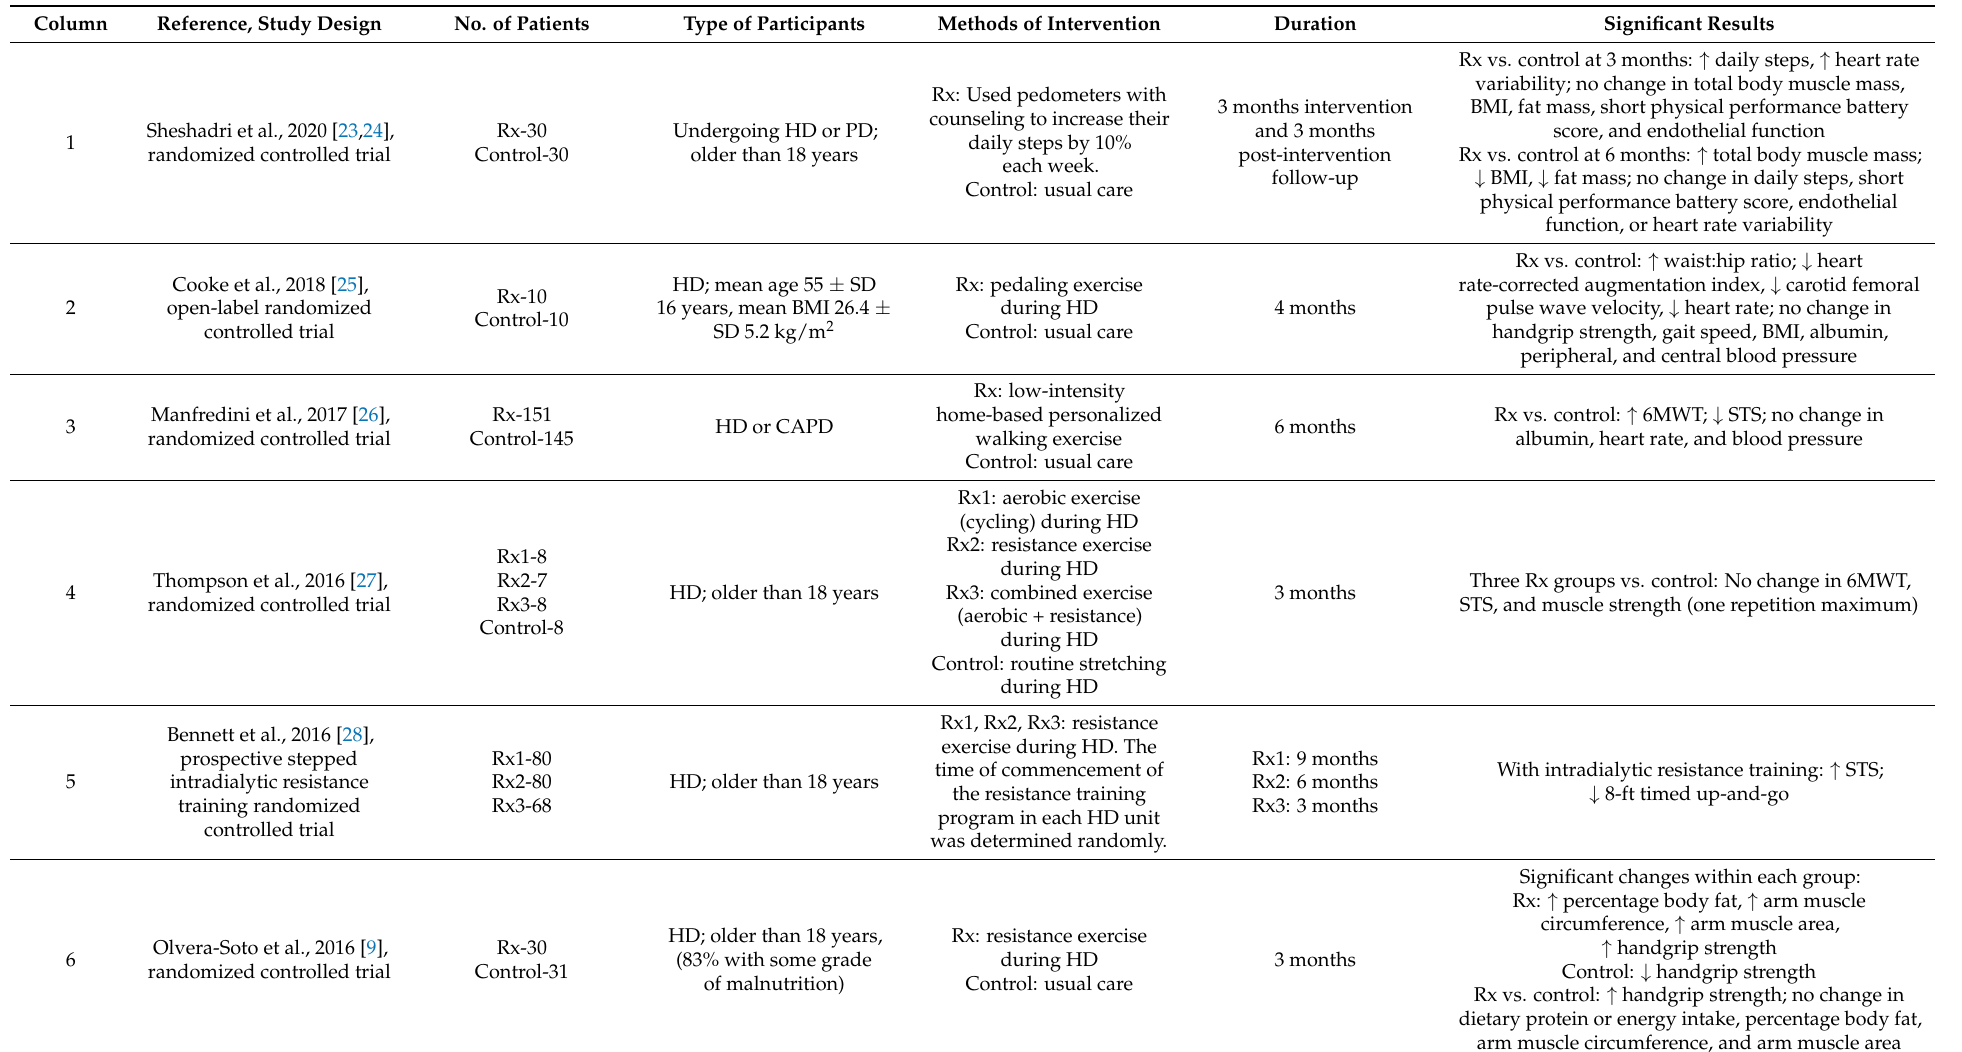
Table 2. Response to exercise training in HD or PD